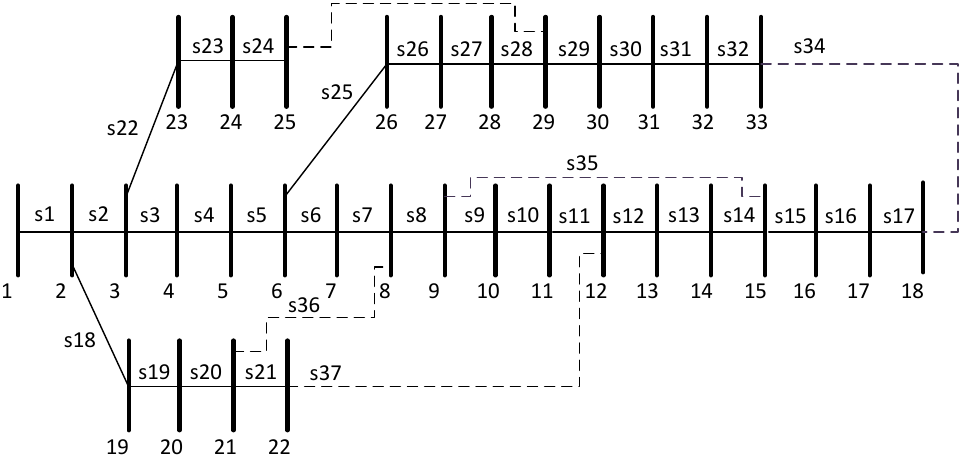
Figure 6. IEEE 33-bus system.